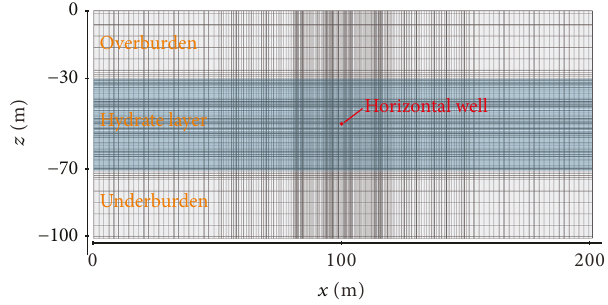
Figure 3: The corresponding grids used in the numerical models, with the location of horizontal well.